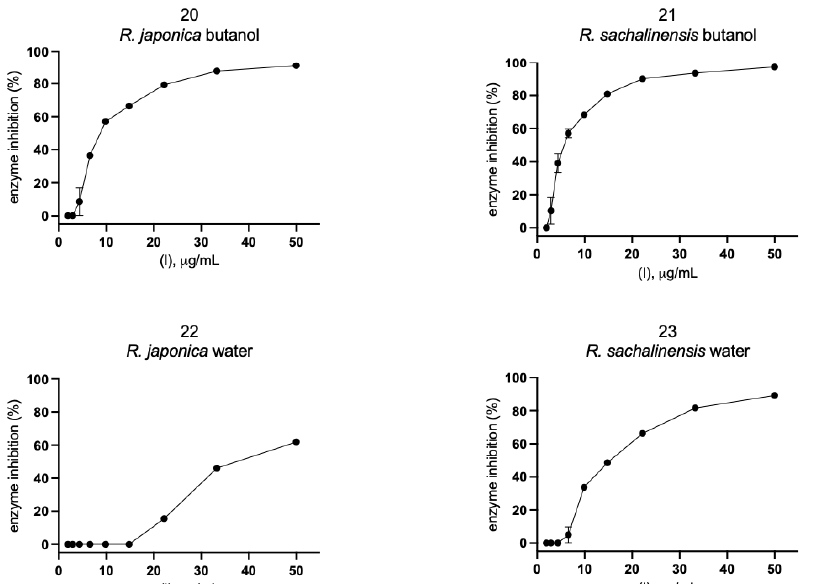
Figure 7. SARS-CoV-2 Mpro activity in serial dilution of extracts and fractions. The results were presented as SARS-CoV-2 Mpro inhibition (%).